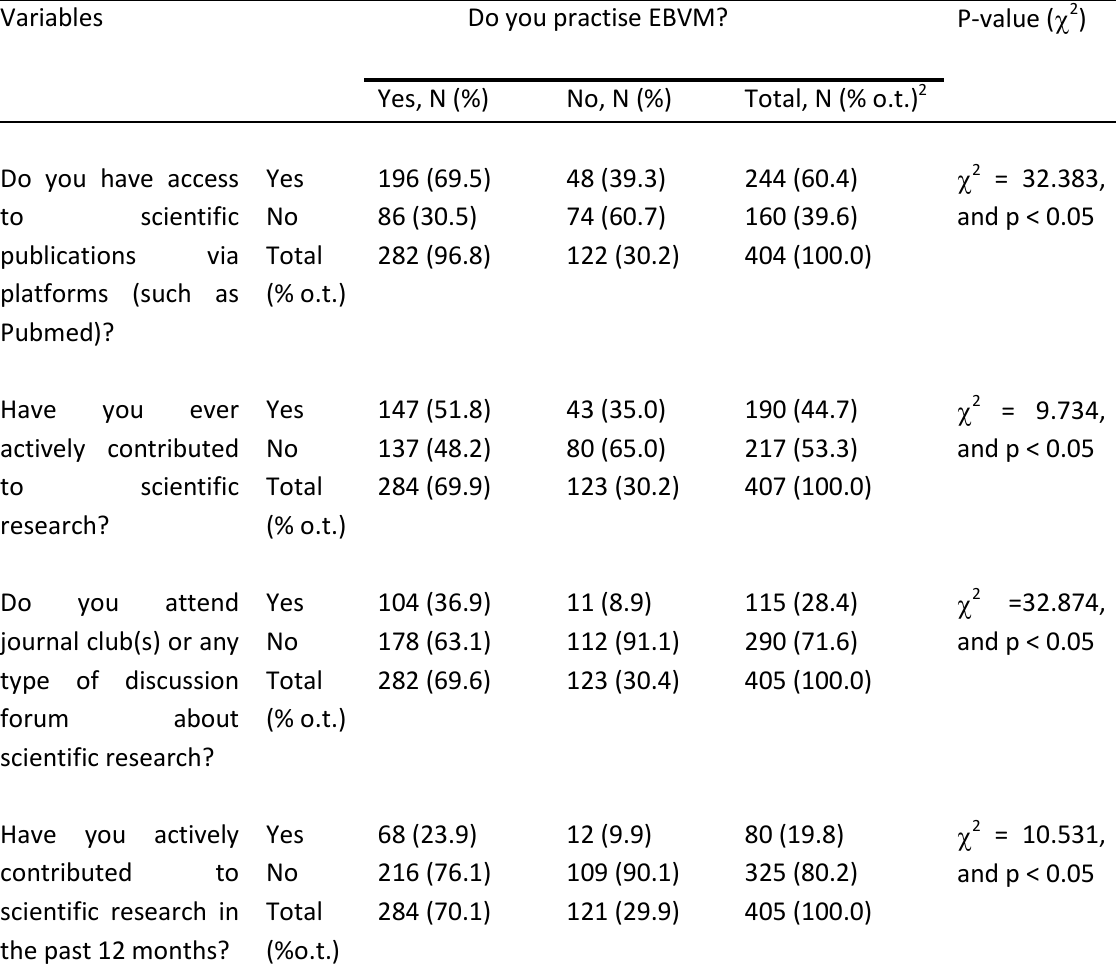
Table 1: Defining EBVM